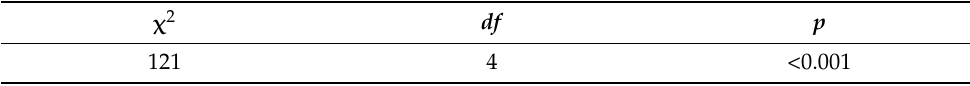
Table 3. Repeated Measures ANOVA Friedman.